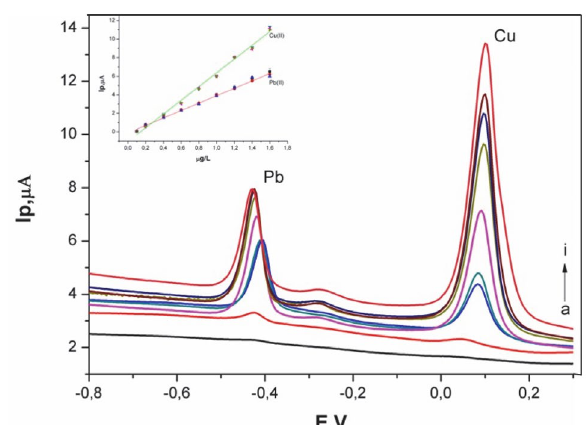
Fig. 8. DPSAV curves of different concentrations of Pb(II) and Cu(II) (a-i, 0.1, 0.2, 0.4, 0.6, 0.8, 1.0, 1.2, 1.4, 1.6 µg L –1 ) at CNT-Ca- lix/CPE in 0.20 M PBS pH 5.0 buffer solution. deposition potential: ‒1.0 V; deposition time: 300 s; pulse amplitude: 0.05 V; pulse width: 0.2 s; scan rate: 0.1 V s ‒1 .